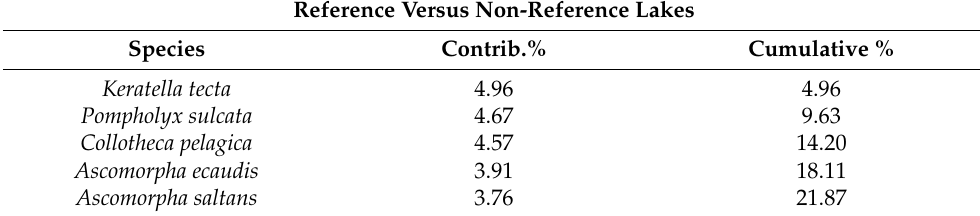
Table 2. Results of the SIMPER analysis for five zooplankton species with highest contribution to differentiation between the reference and non-reference lakes. Data from all samples (lake-years) were analyzed (n =